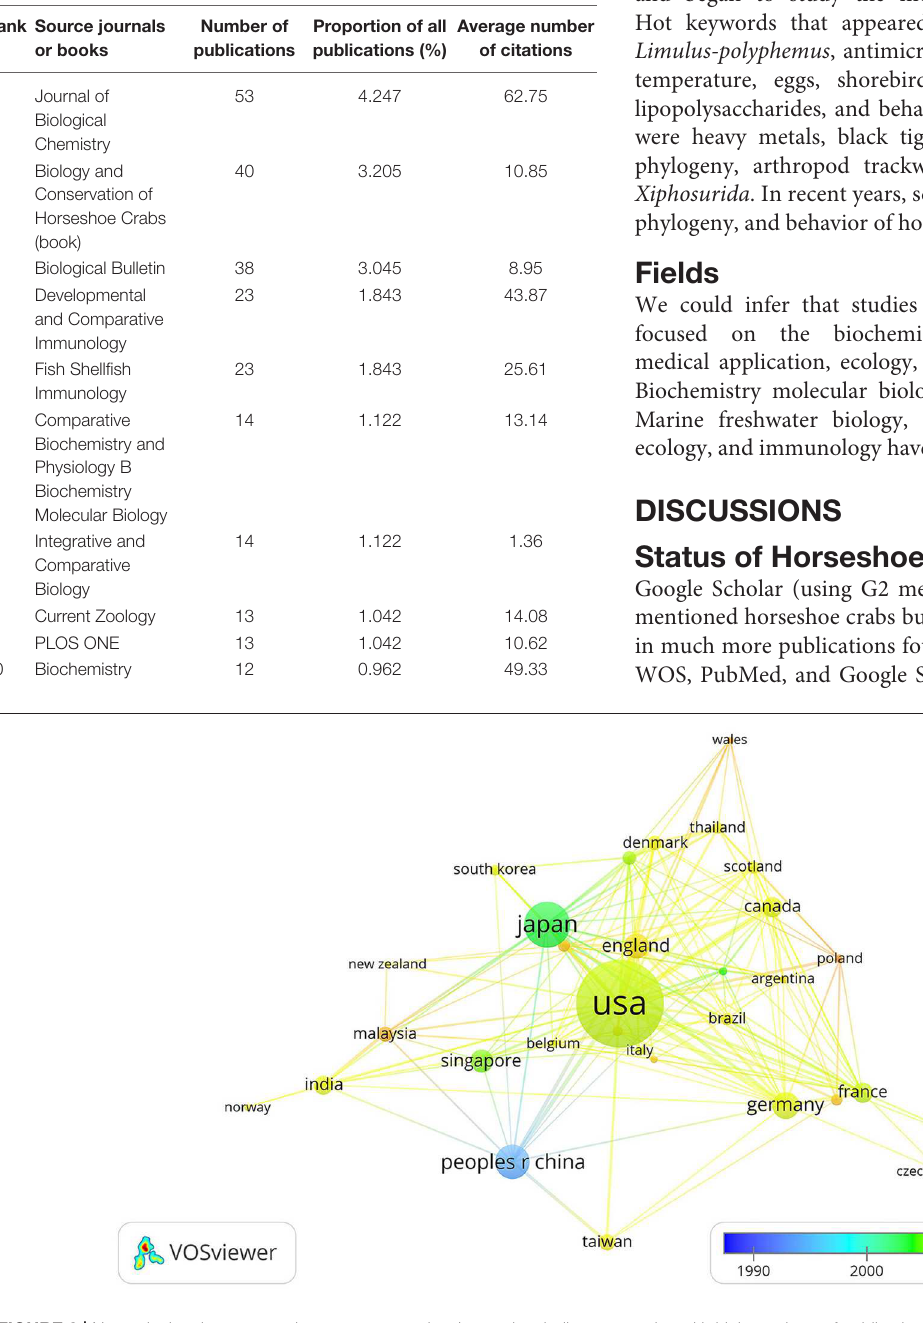
Frontiers in Marine Science |